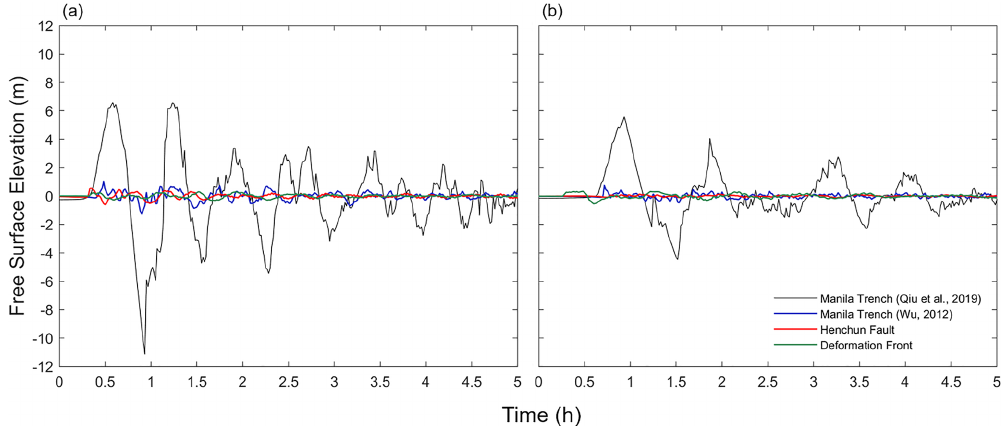
Figure 8. The numerical gauge records at the study sites of (a) Jiateng Harbor and (b)